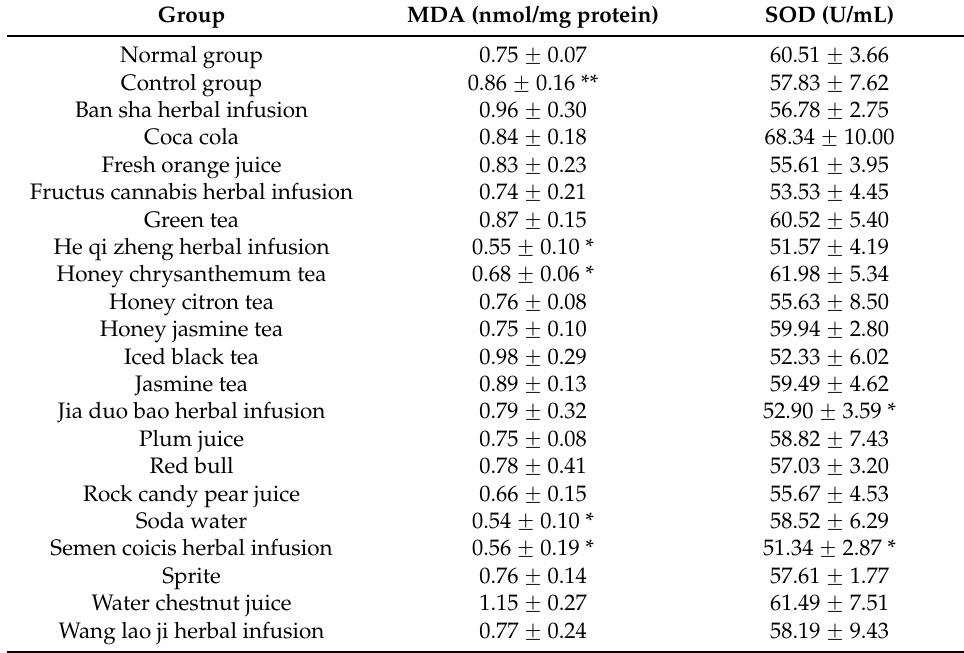
Table 4. Effects of the 20 selected beverages on hepatic MDA and SOD levels in